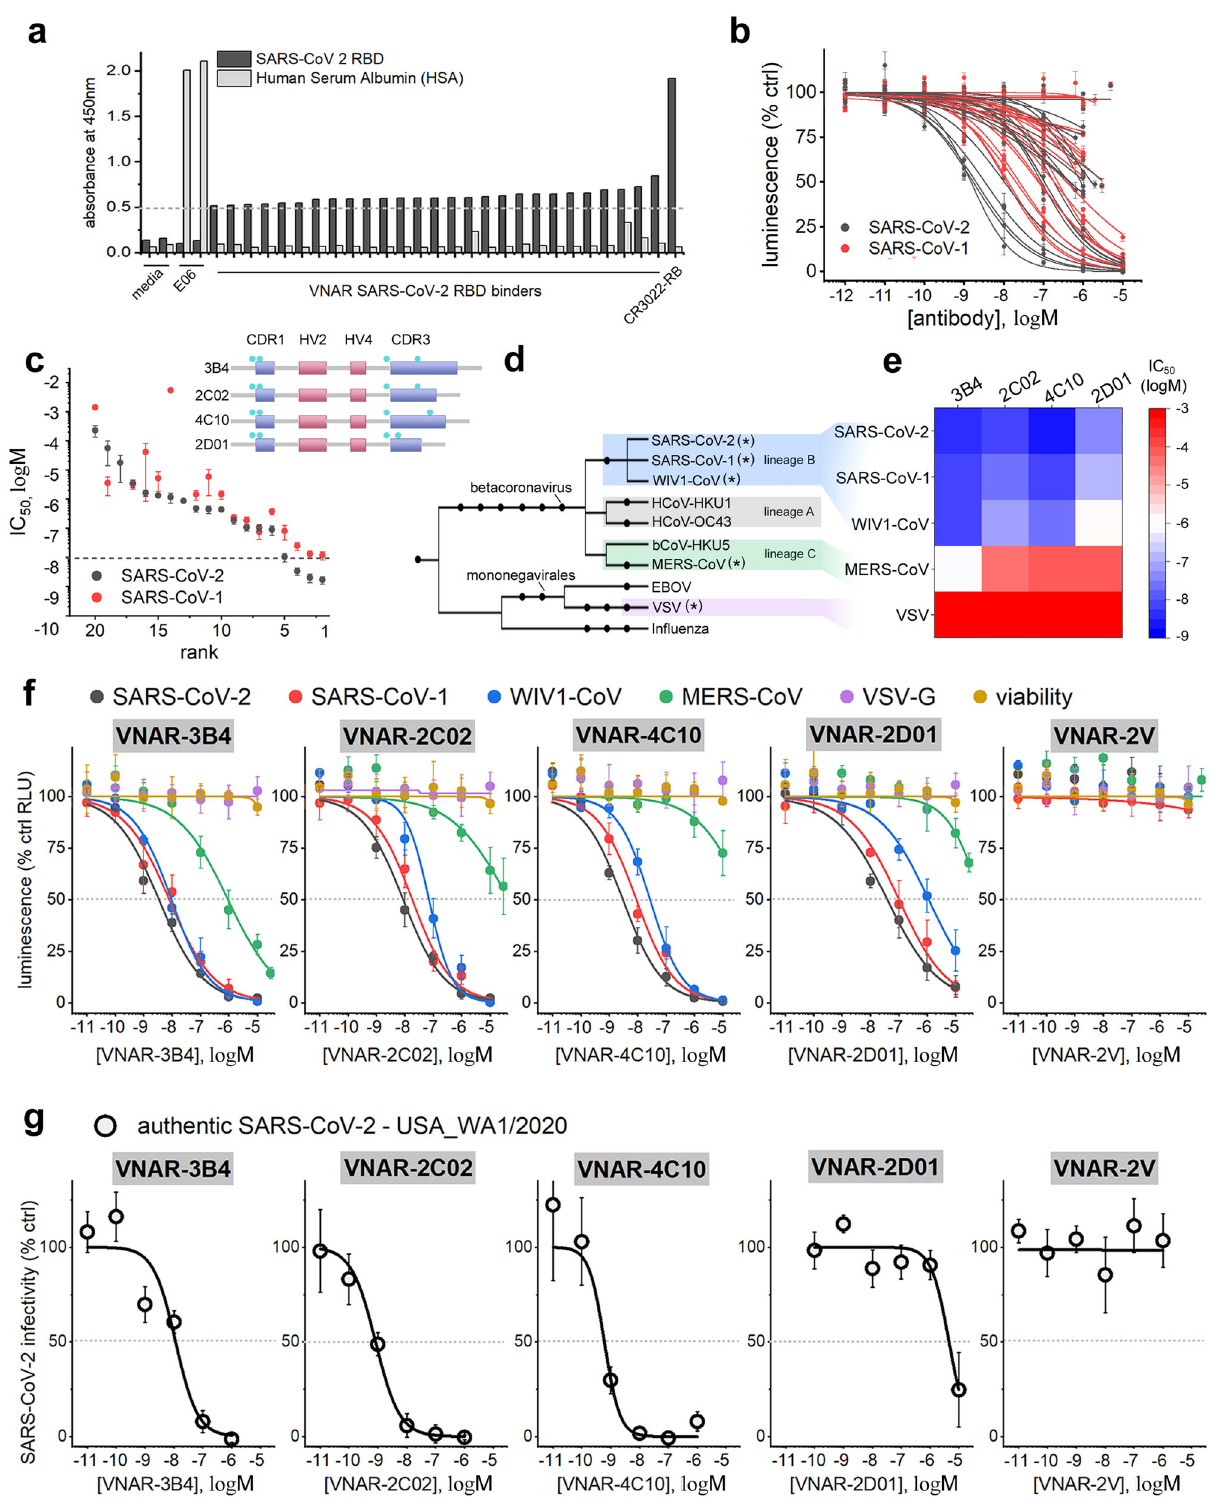
pseudotyped with MERS-CoV spike proteins, a ‘ lineage C ’ beta- coronavirus, despite sharing only 32% sequence homology with SARS-CoV-2 Spike (Fig. 1d – f) 17 . This observation suggests that VNAR-3B4 likely binds to an interface that is evolutionarily conserved among beta-coronavirus lineages. Importantly, the inhibitory activity observed by these VNAR antibodies was speci fi c to coronaviruses and was not due to deleterious effects